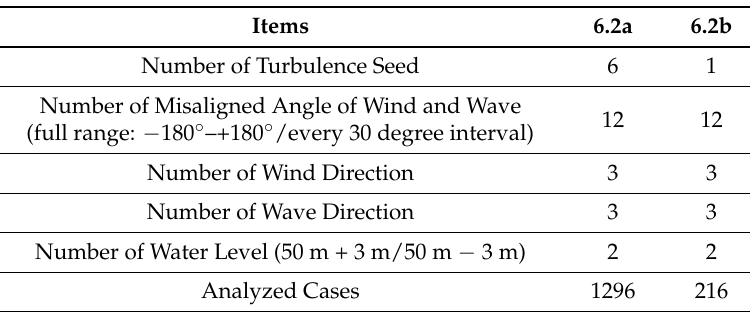
Table 8. Simulation Cases for DLC 6.2a and DLC 6.2b.